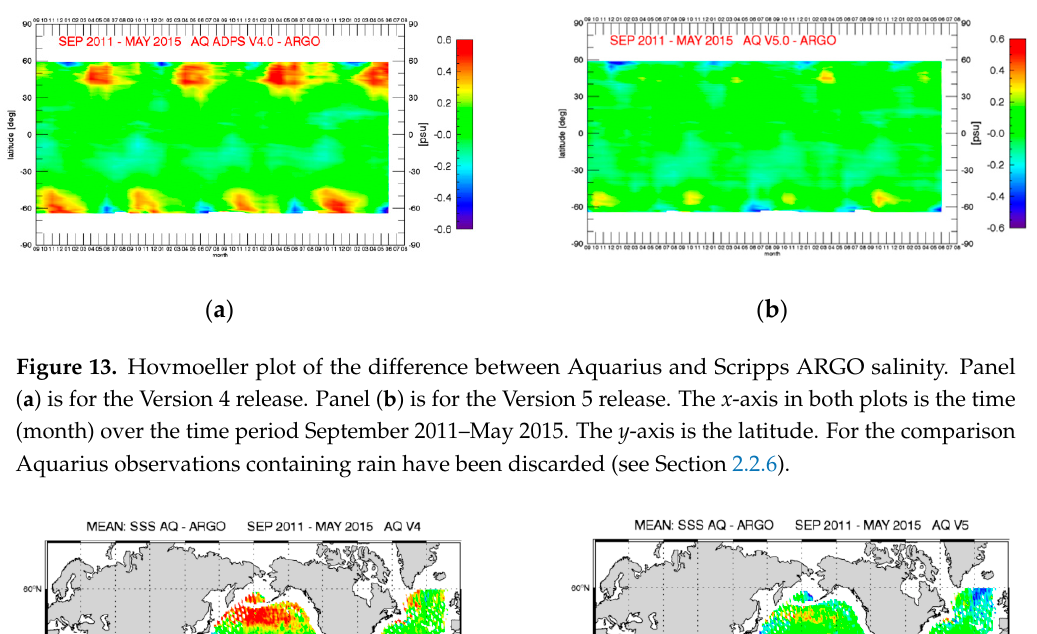
Figure 14. Average difference between Aquarius and Scripps ARGO over the time period September 2011–May 2015. Panel ( a ) is for the Version 4 release. Panel ( b ) is for the Version 5 release. For the comparison observations containing rain have been discarded (see Section 2.2.6).